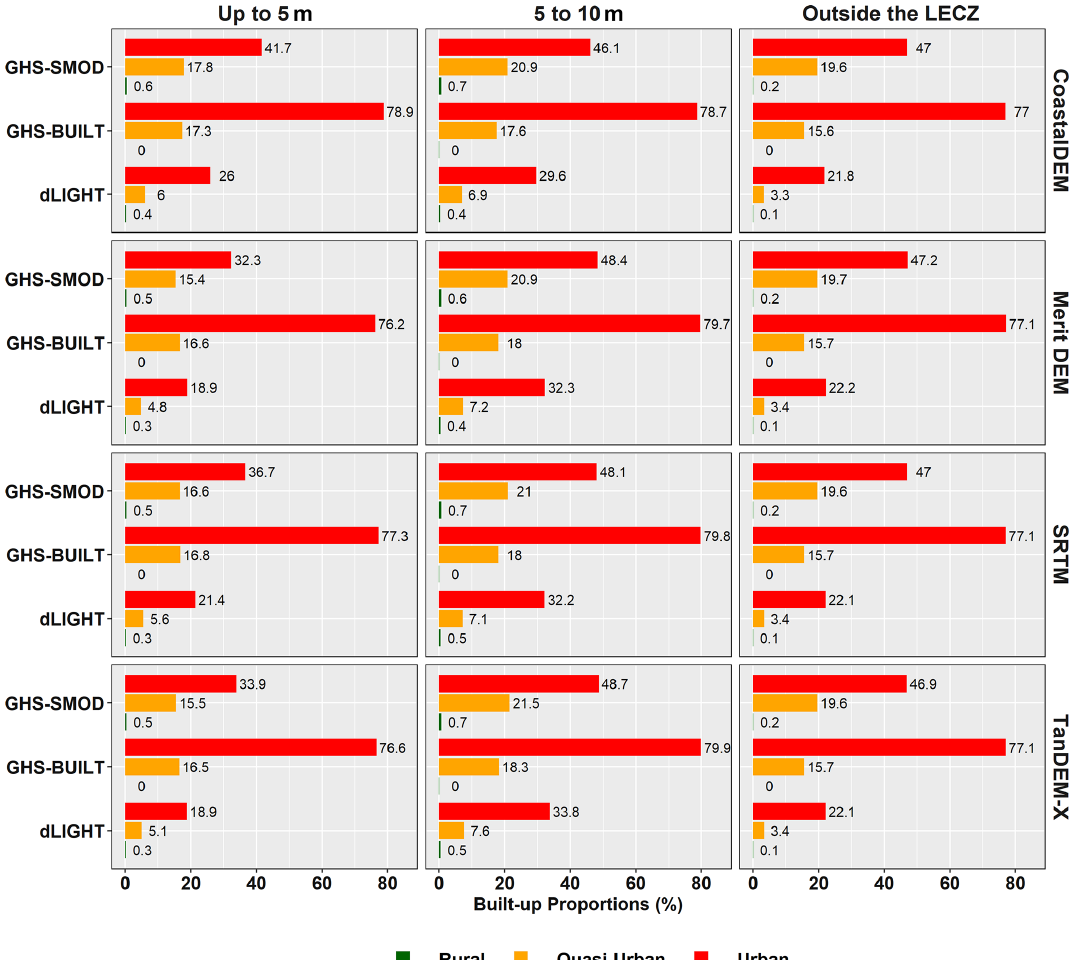
Figure B5. Built-up density (%) of urban, quasi-urban and rural by urban–rural classes, by urban-proxy and election data sets inside and outside of the